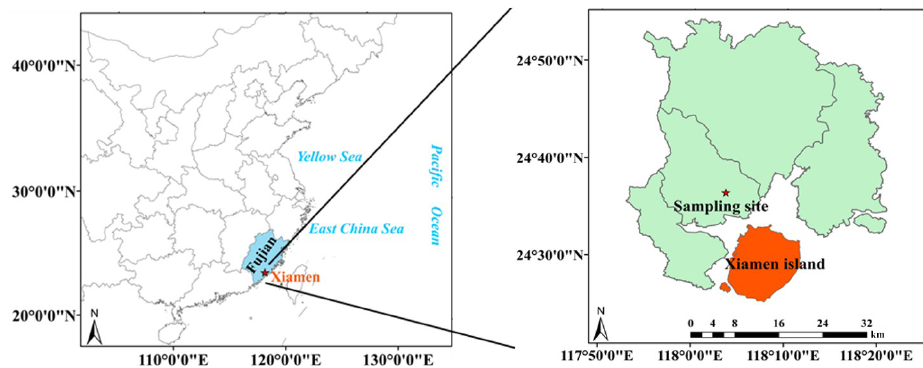
Figure 1. Location of Xiamen and the observation site. Table 1. Estimated degree (during promotion effect scenarios in spring and autumn) of freedom (Edf), degree of 530 reference (Ref. df), P value, F value, deviance explained (%), adjusted R 2 , deviance contribution (%) for the 531 smoothed variables (including NO, (cid:49) RO x , TVOCs, PM 2 . 5 , UV, T , RH, and WS) in the multiple-factor GAM model. Spring Autumn Smoothed variables Edf Ref.df F